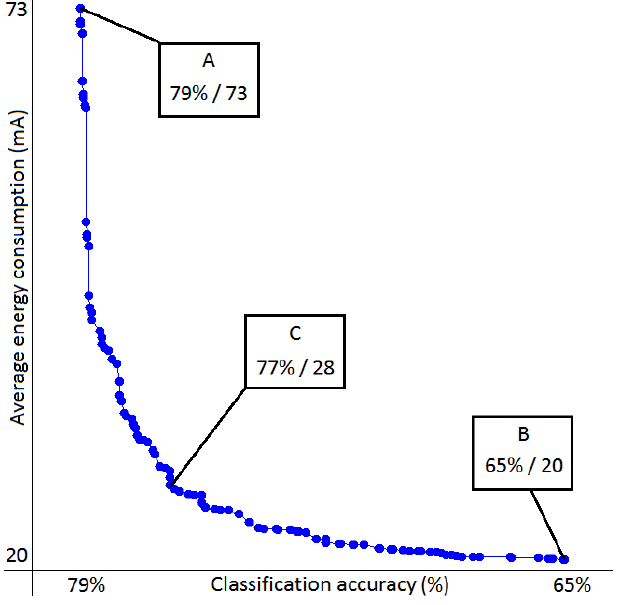
Figure 3. Non-dominated set of assignments evaluated in the Commodity12 experiment. Three points of interest were labeled, and their value is displayed as the classification accuracy (%)/average energy consumption